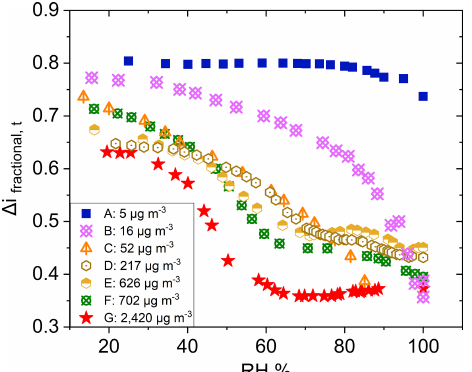
Figure 7. (cid:49)i fractional ,t for α -pinene-derived SOA at various C SOA , from 5 to 2420µgm − 3 , as a function of chamber RH. Figure 8. (cid:49)i fractional ,t inflection point RH (%) as a function of SOA